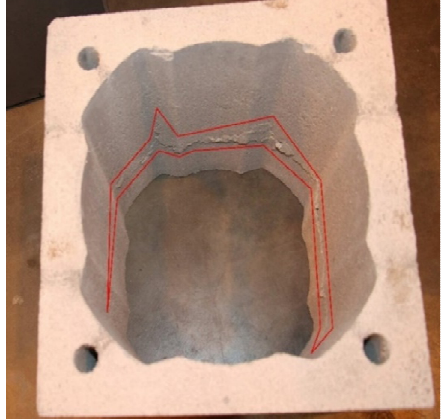
Figure 11. Visible damage caused by compressive load.